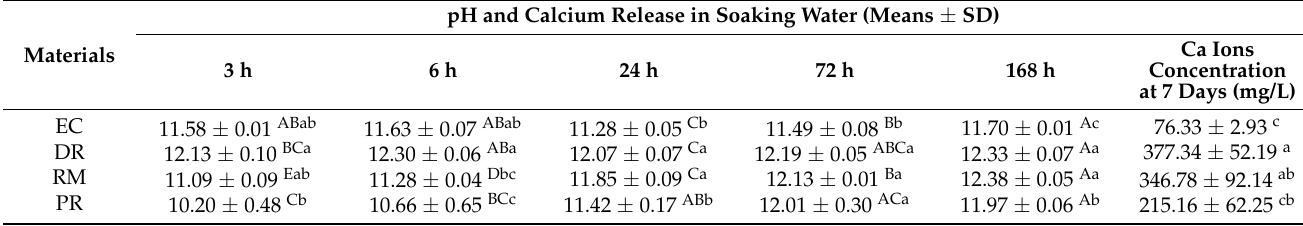
Table 3. pH variation and calcium ion release (mg/L) in soaking solution for 7 days.